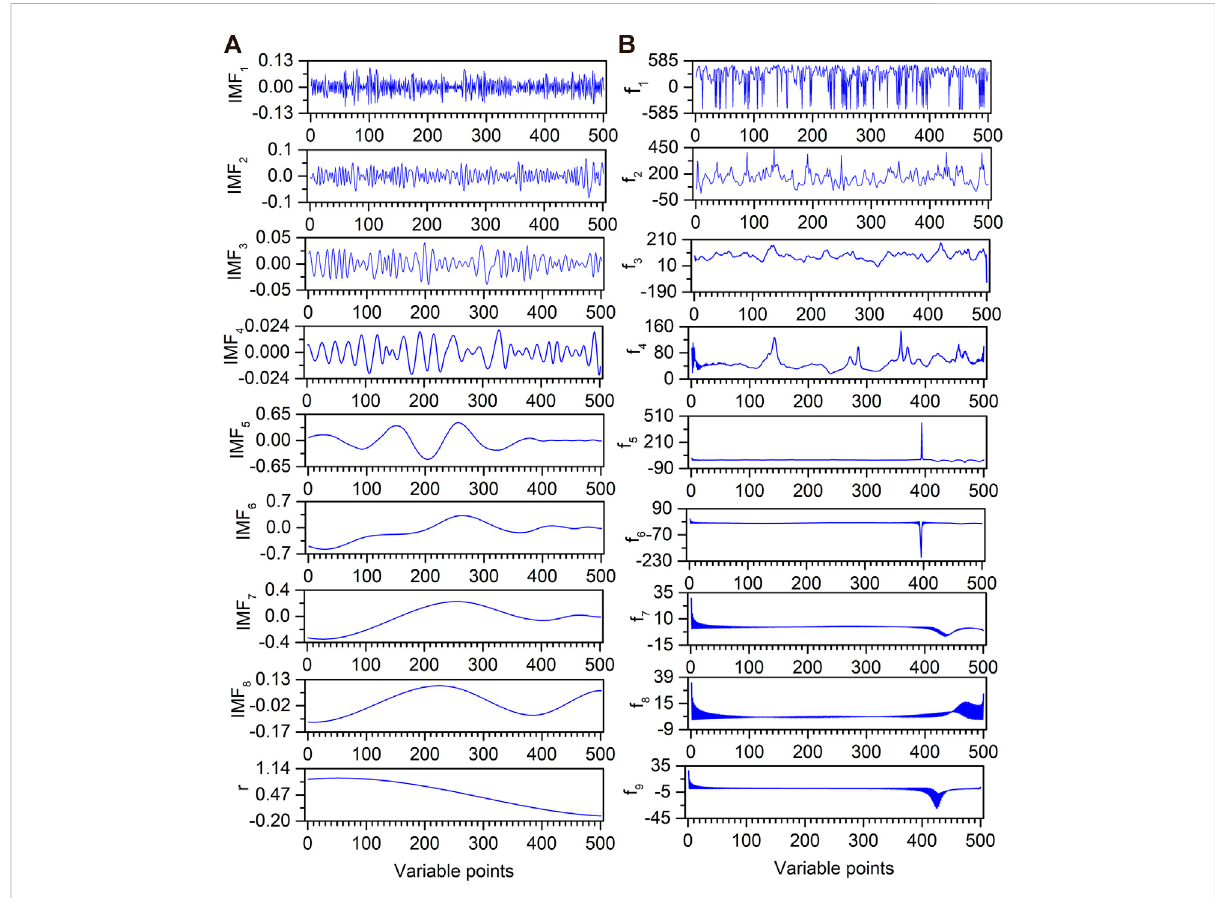
FIGURE 5 EMD decomposition results (A) and their corresponding instantaneous frequencies (B) for arti fi cially chemical noised